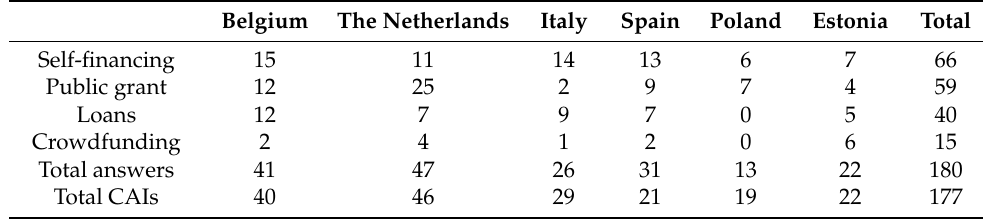
Table 7. Other relevant sources of financing for